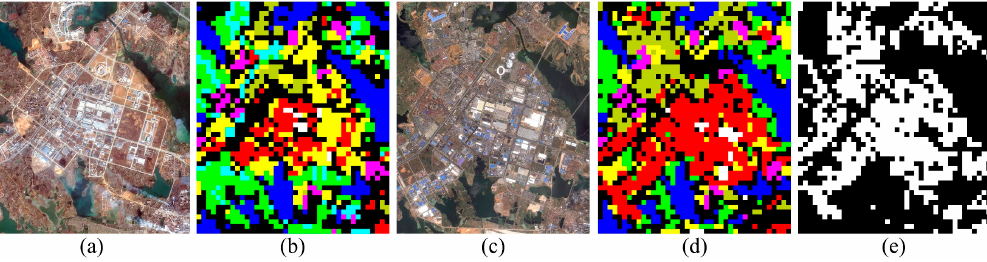
Figure 6. Multi-temporal Scene WuHan Dataset, obtained in ( a ) 2002 and ( c ) 2009; ( b ) Scene category label-2002; ( d ) Scene category label-2009; ( e ) Ground truth, where white indicates changed region and black indicates the unchanged region.